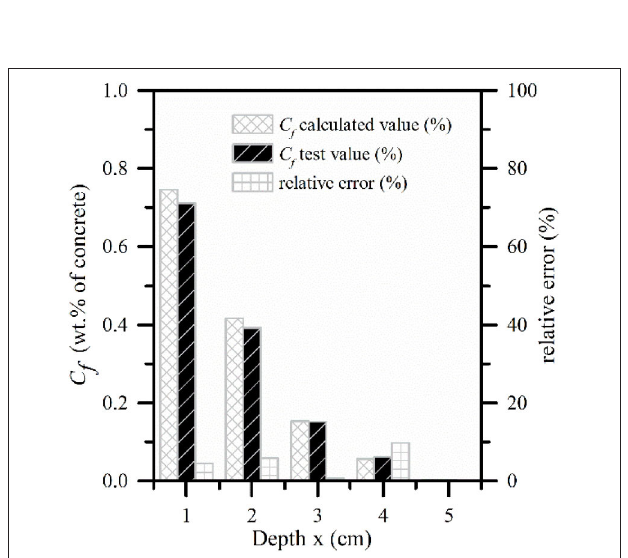
FIGURE 4 | Error analysis of calculation value and test